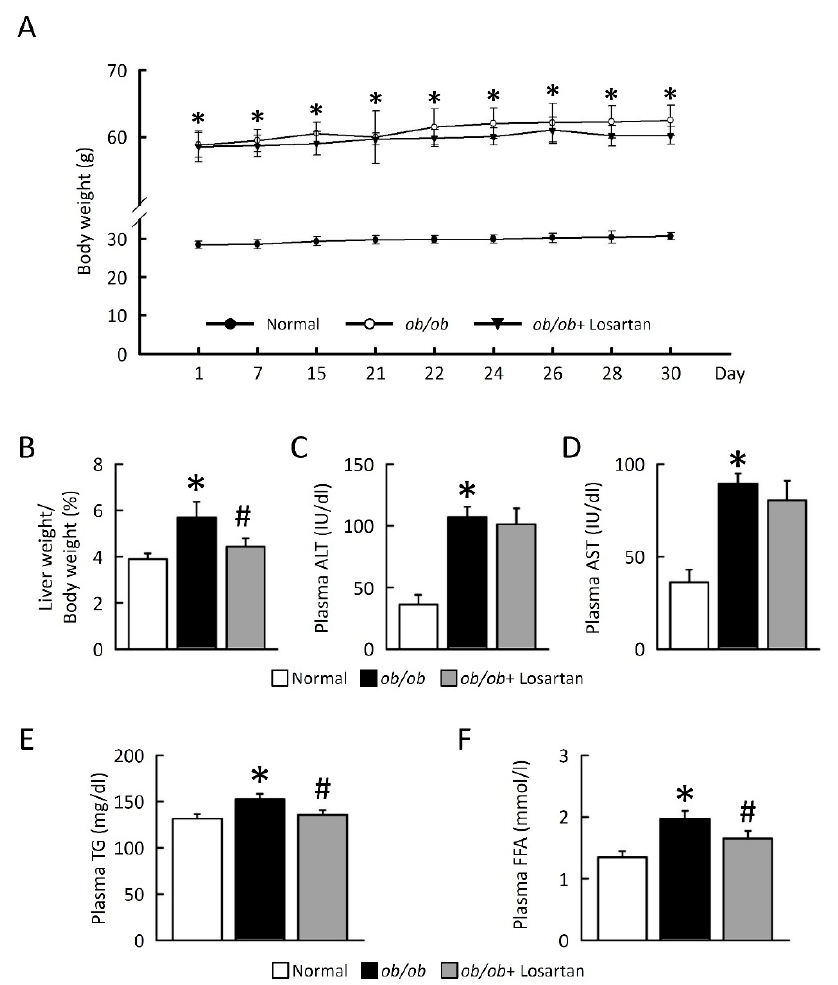
Figure 1. Losartan attenuated NAFLD development in ob/ob mice. ( A ) Body weight (g). ( B ) Liver weight/body weight (%). ( C ) Plasma ALT (IU/dL). ( D ) Plasma AST (IU/dL). ( E ) Plasma TG (mg/dL). ( F ) Plasma FFA (mmol/L). For each animal group, n = 5. All values represent the mean ± SEM. Data were analyzed by Student’s t test. * p ≤ 0.05; normal vs. ob/ob . # p ≤ 0.05; ob/ob vs. ob/ob + Losartan. ALT, alanine transaminase; AST, aspartate aminotransferase; TG, triglyceride; FFA, free fatty acid.